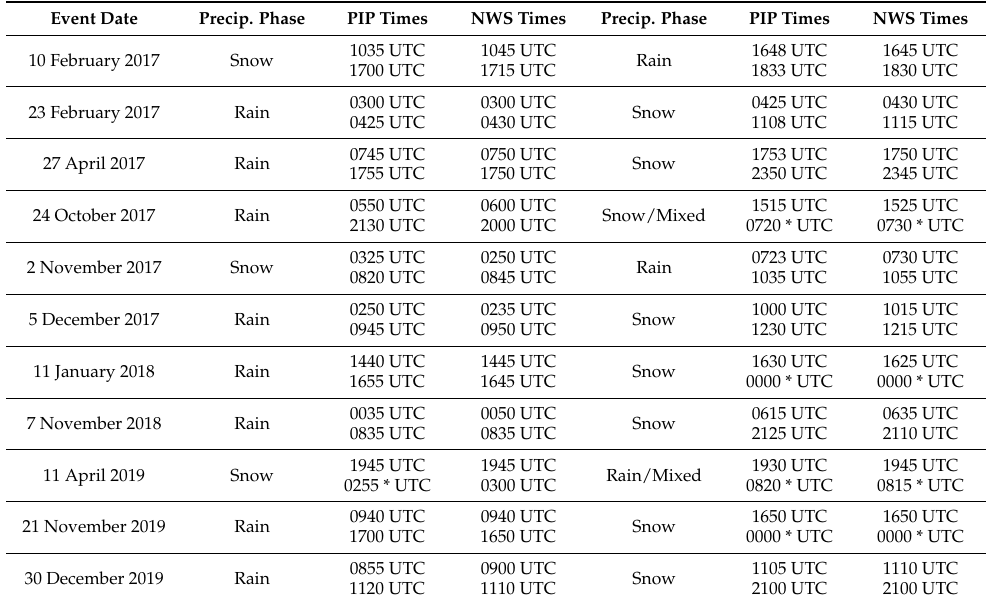
Table 1. Events with a single precipitation phase transition with observations from the PIP and the NWS MQT forecaster records. * Denotes +1 day UTC from start date. Precip. Phase PIP Times NWS Times Precip.